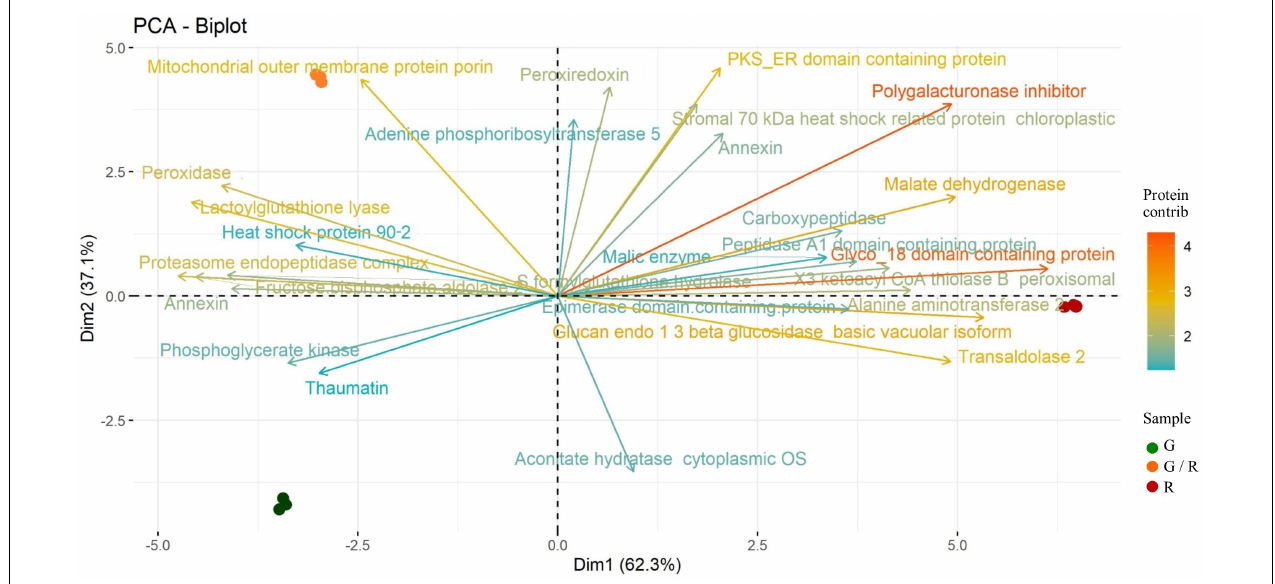
FIGURE 3 | Two-dimensional principal component analysis (PCA) biplot showing associations between experimental samples and protein abundance generated by PCA. The 1st and 2nd component (PC 1 and PC2, respectively) are displayed. Samples are distributed according to their ripening stage: G (green), G/R (green/red), and R (red). The 30 proteins (vectors) with highest contribution are individually